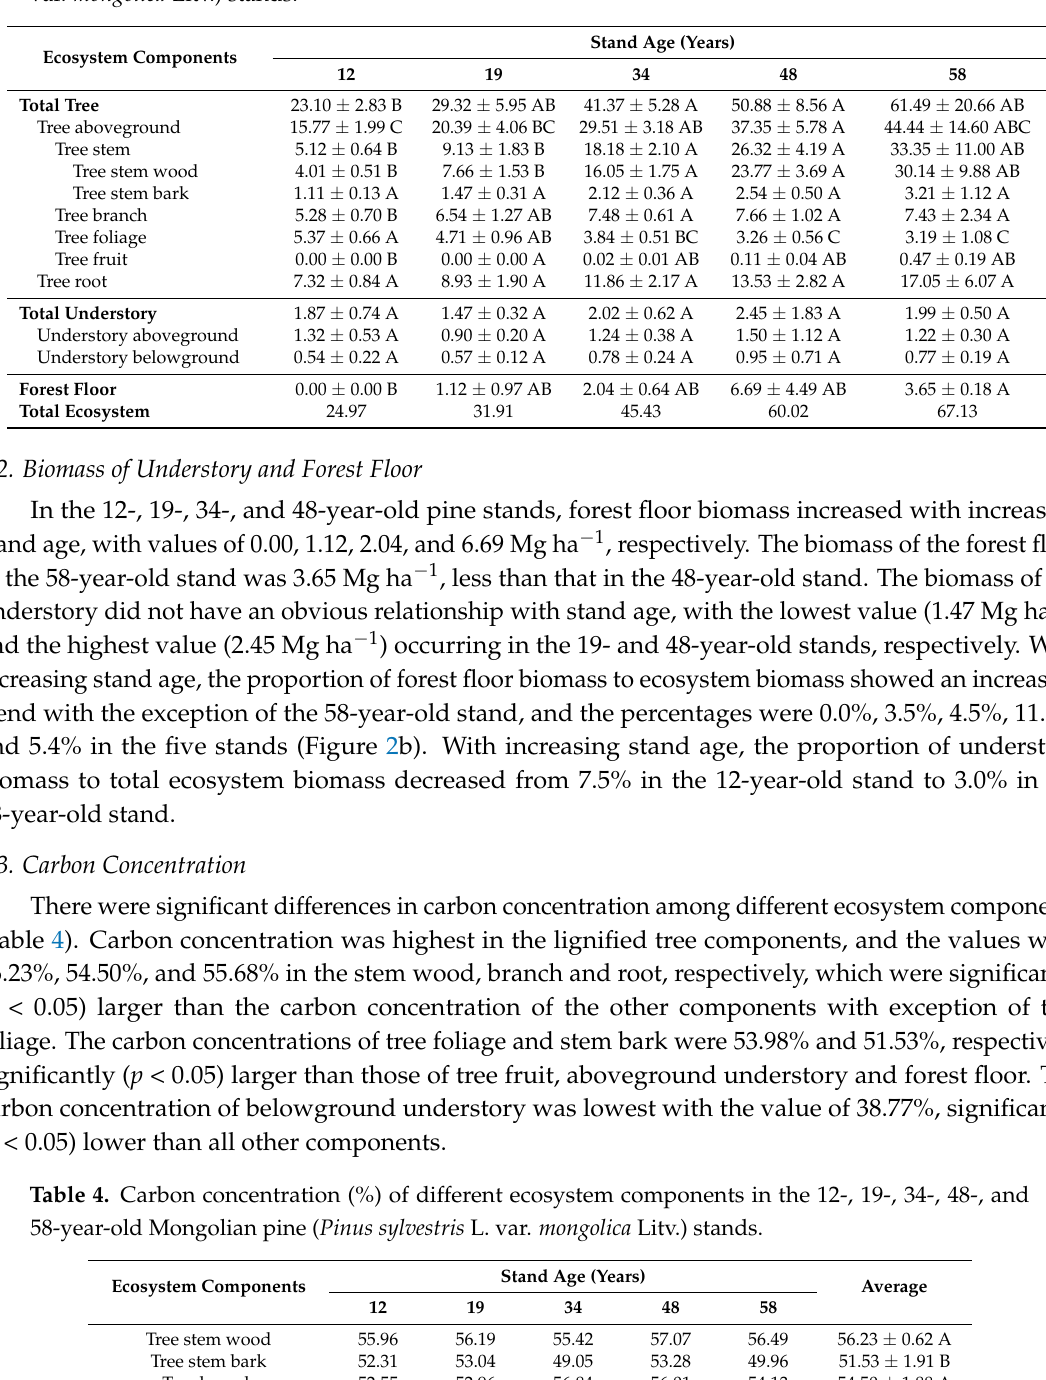
Table 3. Biomass of the ecosystem components (the mean value with the standard error followed by different uppercase letters are significantly different at p < 0.05, Mg ha − 1 ) (including tree components, understory and forest floor) in the 12-, 19-, 34-, 48-, and 58-year-old Mongolian pine ( Pinus sylvestris L. var. mongolica Litv.) stands.